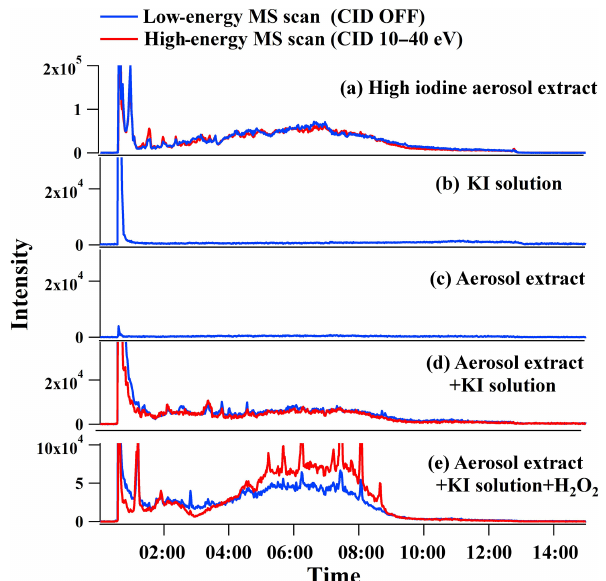
Figure 3. Ion chromatograms of m/z 126.9039 of (a) aerosol extract with high concentration of iodine, (b) pure potas- sium iodide (KI) solution (1mmolL − 1 ), (c) aerosol extract with low concentration of iodine, (d) the KI solution mixed with the aerosol extract with low concentration of iodine, and (e) the KI solution + aerosol extract mixture with the addition of 10mmolL − 1 H 2 O 2 solution. Blue curves: low-energy MS scan mode, in which collision-induced dissociation (CID) is off and molecular ions are subject to in-source fragmentation only. Red curves: high-energy MS scan mode, in which molecular ion are subject to both in-source fragmentation and 10–40eV collision- induced